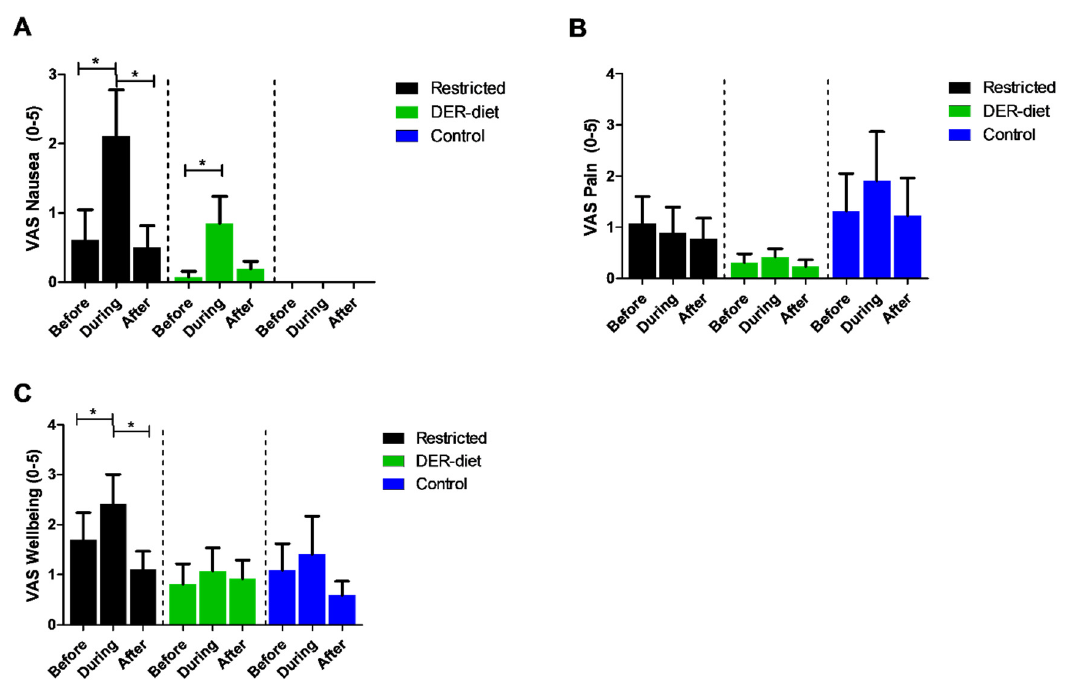
Figure 2. Visual Analogue Scores (VAS) for nausea, pain, and wellbeing before, during, and after each dietary intervention. ( A ) The nausea scores increased significantly for patients on the restricted diet and the DER ‐ diet but normalized to baseline levels directly after the intervention period was over; ( B ) The pain scores did not change significantly during the dietary interventions; ( C ) The restricted diet resulted in significant decreased VAS wellbeing scores during the diet compared to before, but normalized again directly after the intervention period was over; * p < 0.05. Bars represent the standard error of the mean; DER = daily energy requirements.